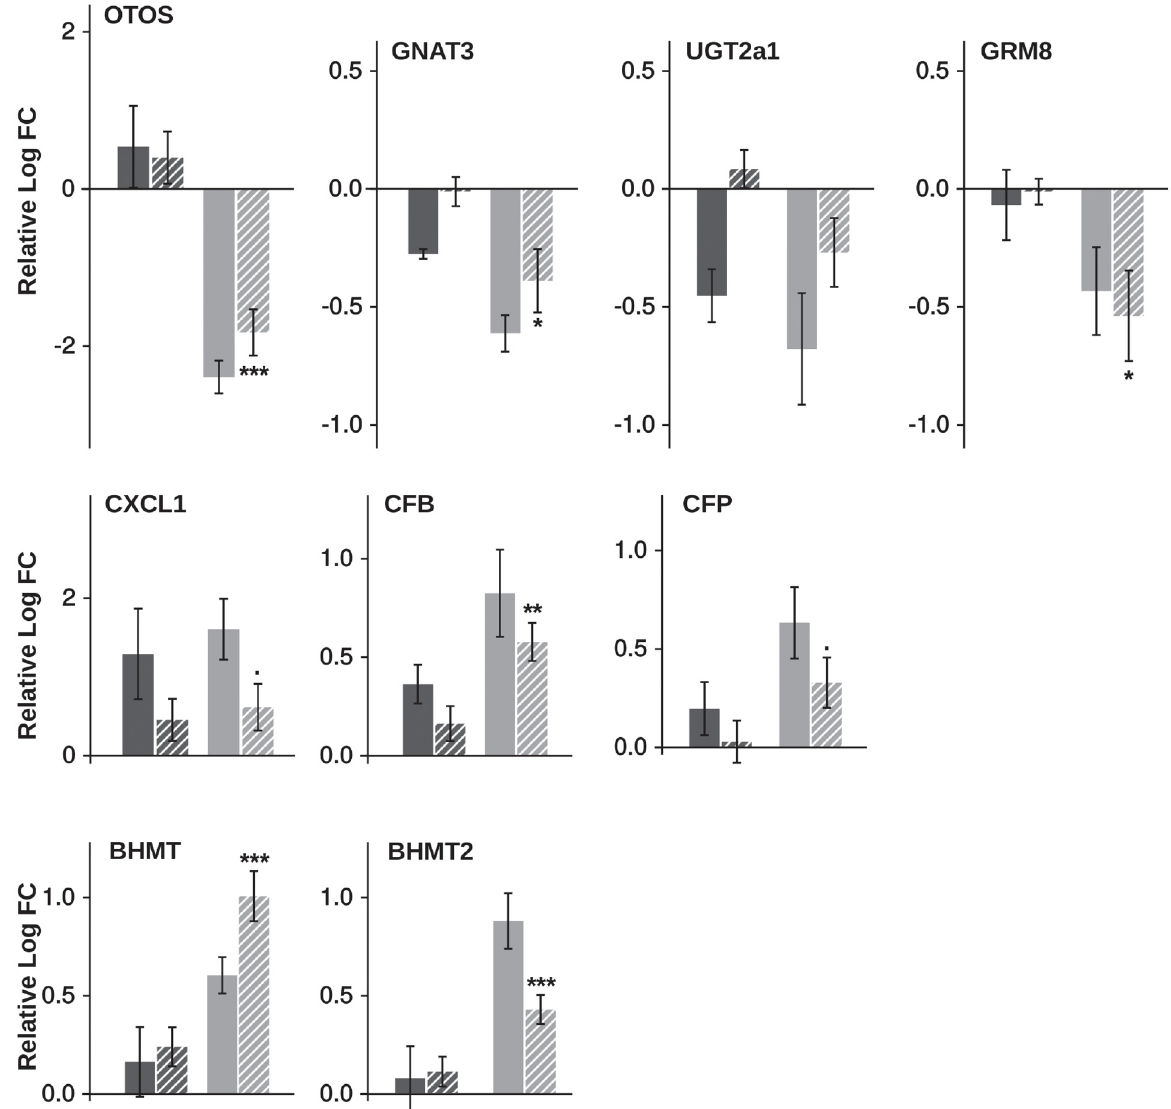
Fig 4. qPCR results. Fold changes obtained by microarray (fill) and by qPCR (hatched) when fed the M diet (dark grey) or the V diet (light grey) for genes involved in sensory perception (R23h versus A22h), immunity (R23h versus AB1h) and for amino acid metabolism (R23h versus A22h).